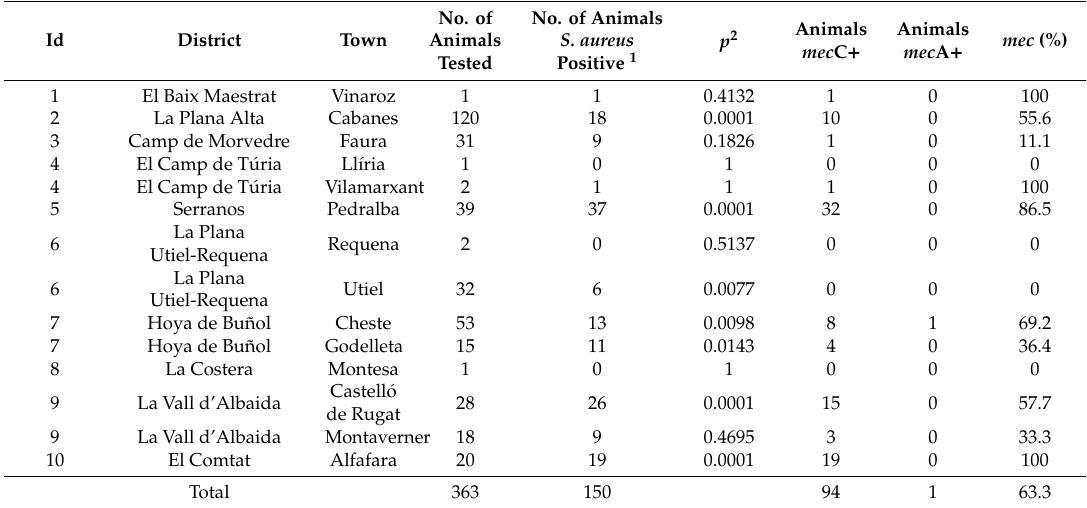
Table 2. Animals positive for S. aureus and MRSA in the di ff erent studied districts.